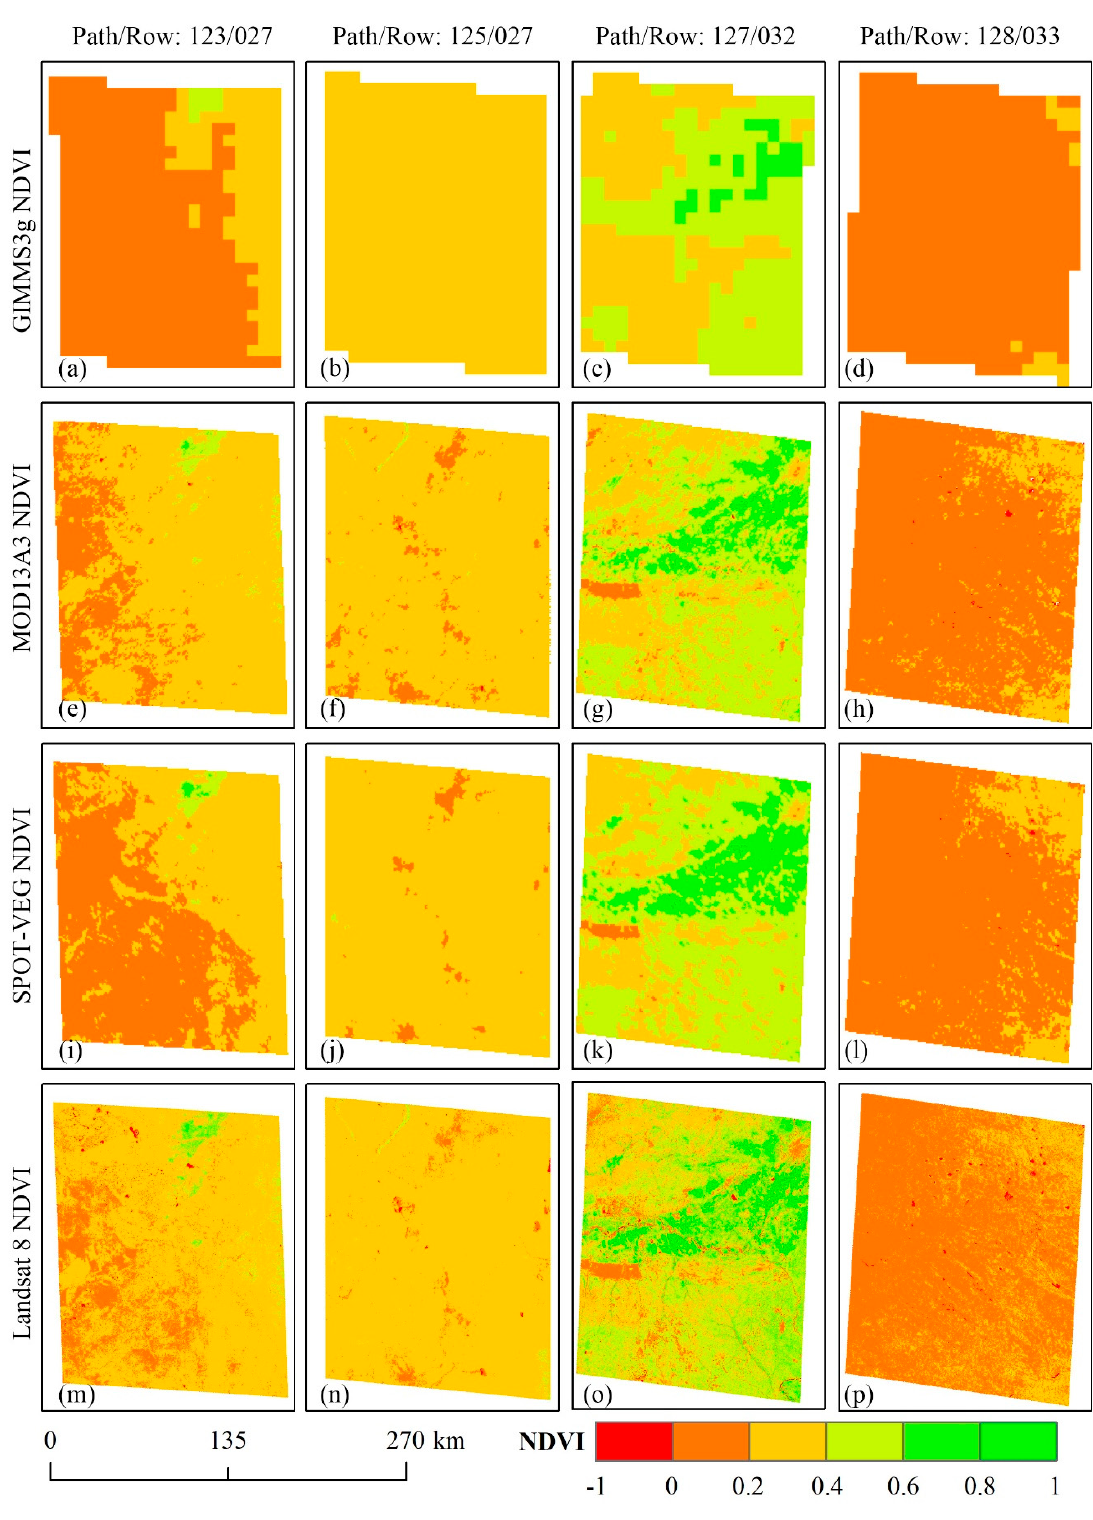
Figure 13. Contrastive analysis of GIMMS3g NDVI ( a – d ), MOD13A3 NDVI ( e – h ), SPOT-VGT NDVI ( i – l ) and Landsat 8 NDVI ( m – p ) in different time and space ranges. The Path/Row in the figure represents the path and row number of Landsat 8 images.